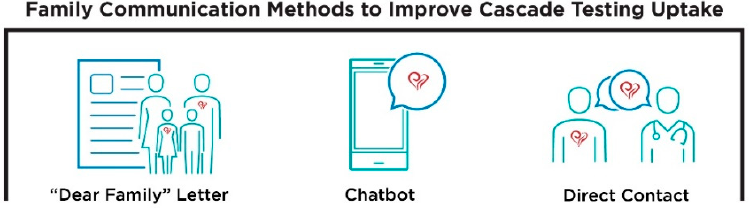
Scenario 1: Your patient recently received a diagnosis for familial hypercholesterolemia (FH).